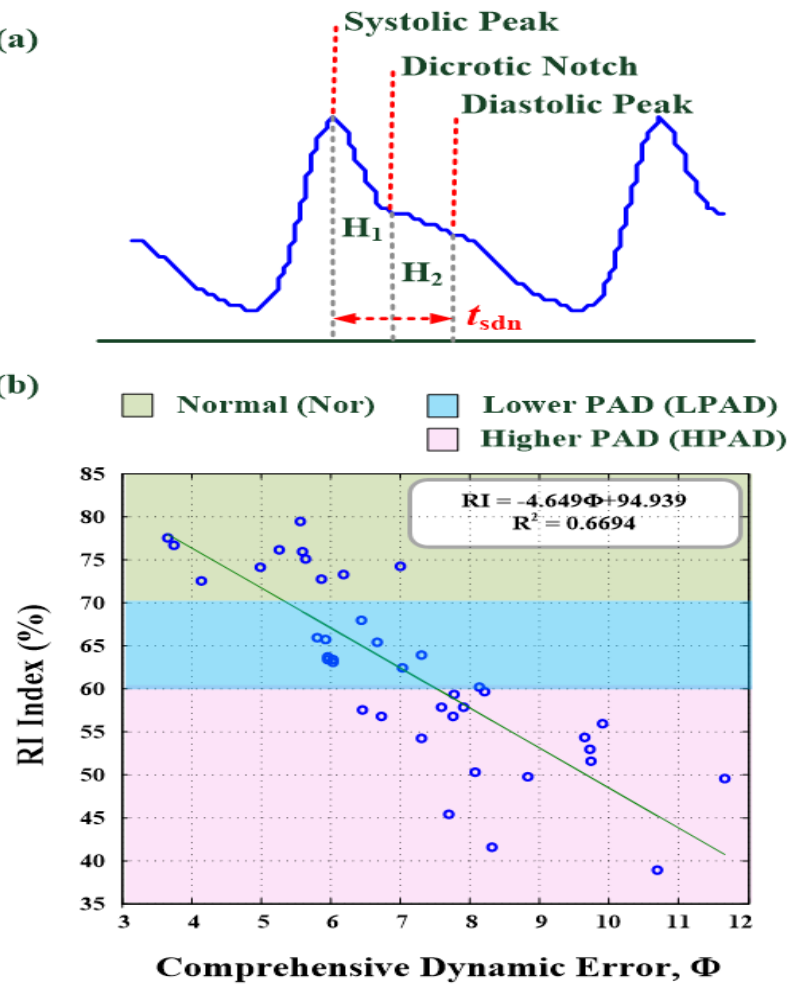
Figure 4. ( a ) One PPG waveform consisting of a systolic peak (systole region), dicrotic notch, and diastolic peak. ( b ) Linear regression predictor ( R 2 = 0.6994) for the reflection index and comprehensive dynamic error, Φ.